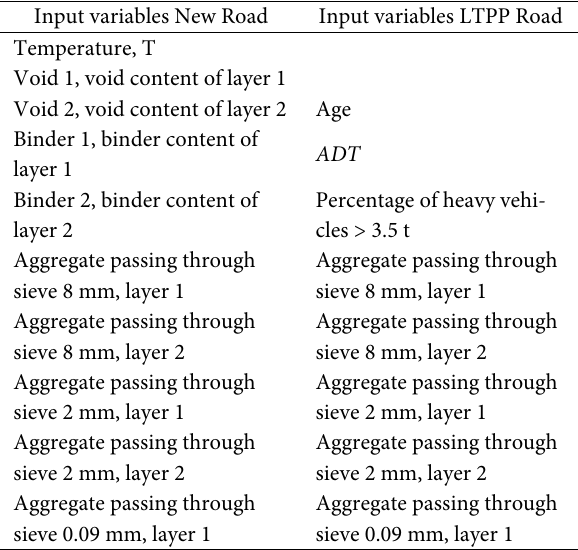
Table 4. Input variables for New Road and LTPP Road datasets Input variables New